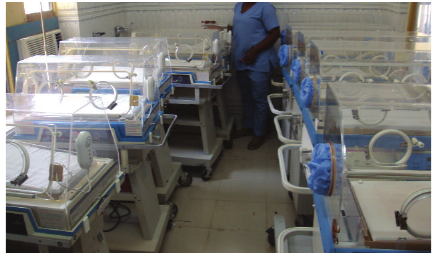
Figure 3: New RIT-fleet at UBTH Benin-City. Casings were sent from the USA through BRONDEK partnership Atlanta Georgia.